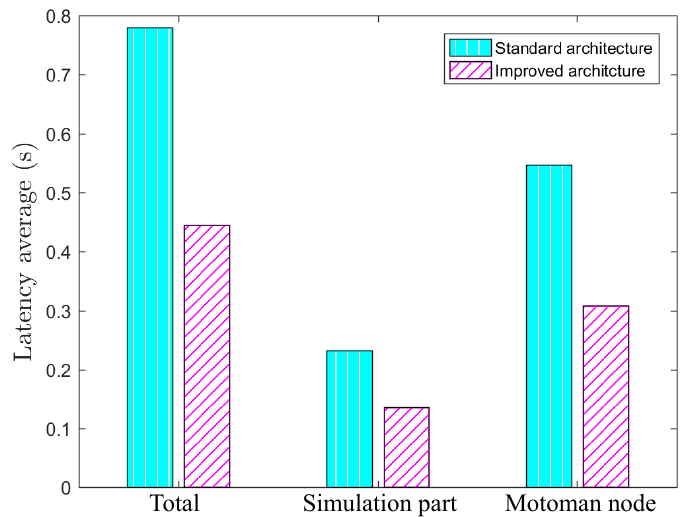
Figure 8. Average latency while using the standard and the improved control